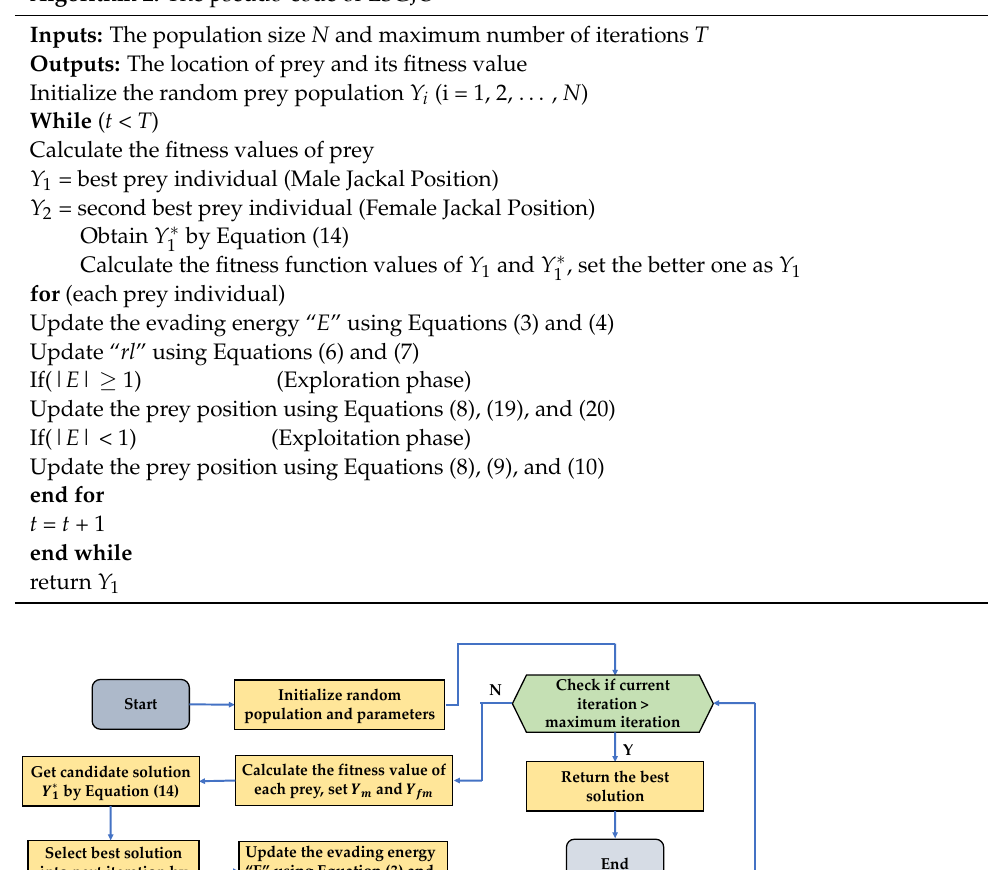
Figure 2. The principle of the dual golden spiral update rules. Algorithm 2: The pseudo-code of LSGJO